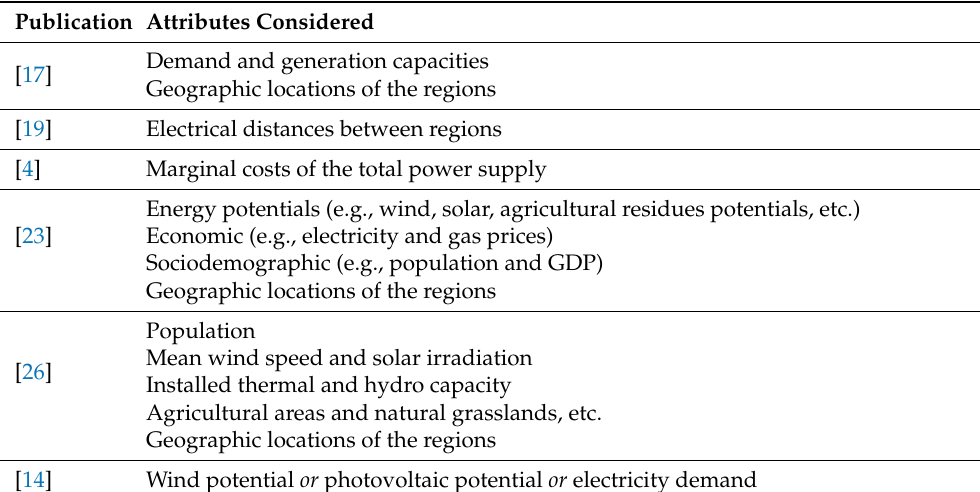
Table 1. The attributes consideredduring spatial aggregation in the previous